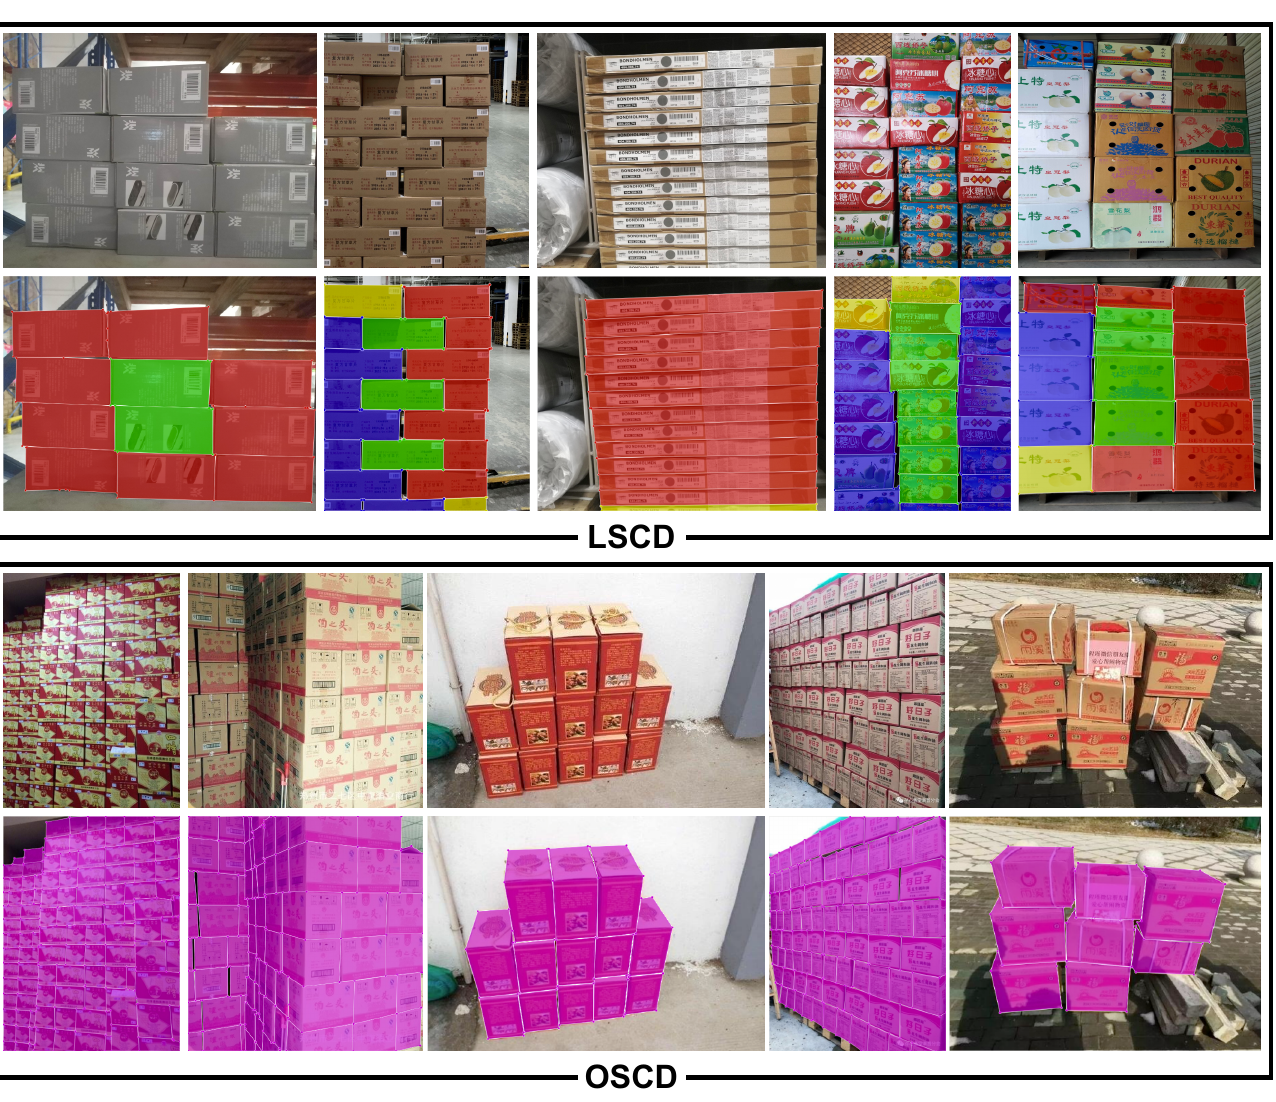
Figure 1. Example of instance annotation in SCD. The first first box represents the style of four labels with respect to LSCD, while the second box illustrates the style of one label in OSCD. In terms of the first box, blue, green, red, and yellow represent Carton-inner-occlusion, Carton-inner-all, Carton-outer-all, and Carton-outer-occlusion, respectively. In terms of the second box, the OSCD only contains the “Carton” label which uses purple